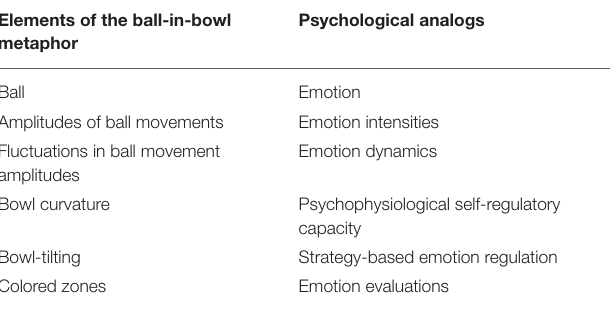
TABLE 1 | Elements of the ball-in-bowl metaphor and their psychological